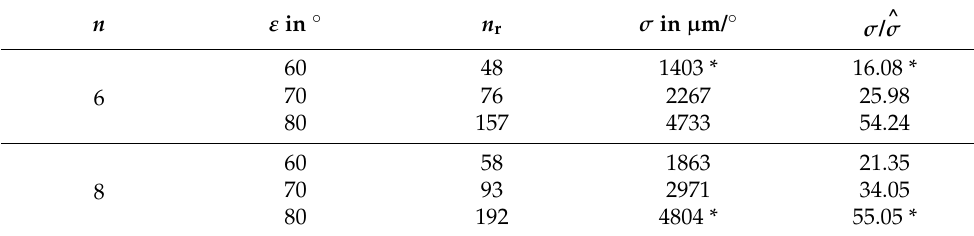
Table 2. Number of reflections n r local sensitivity σ and gain factor σ /ˆ σ at ϕ = 0 for different numbers of faces n and coupling angles ε decentral coupling ( e = 1